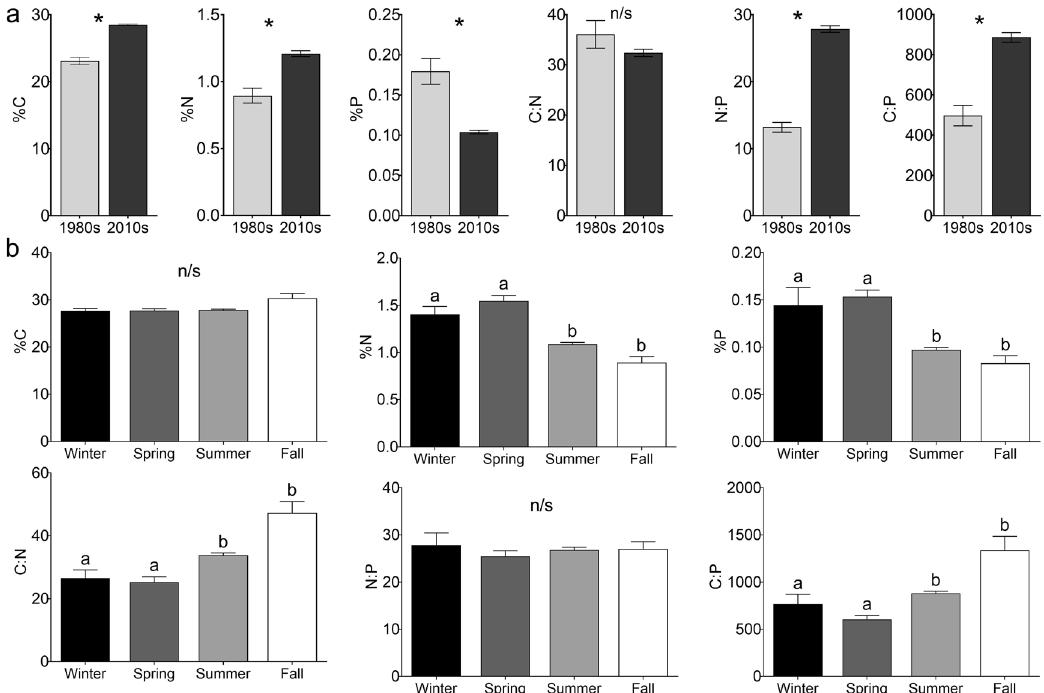
Fig. 2 Sargassum tissue nutrient contents. Tissue elemental composition and C:N:P stoichiometry (mean ± SE) of Sargassum natans and S. fl uitans collected throughout the NA in the 1980s and post-2010. a by decade with asterisks representing signi fi cant differences and b by Northern Hemisphere meteorological season with different lowercase letters representing signi fi cant differences identi fi ed with Tukey HSD test; “ n/s ” denotes a non-signi fi cant ( P > 0.05) ANOVA